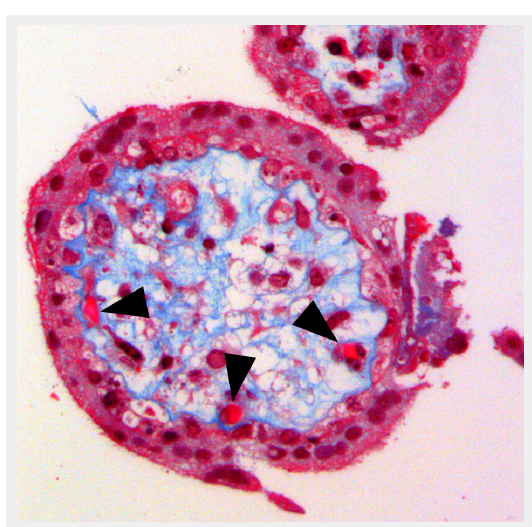
Histomorphology of a chorionic villus showing the outer trophoblastic coverage surrounding the inner foetal mesenchyme also comprising the foetal capillaries (black arrows). (Reprinted from: Weber B, Zeisberger SM, Hoerstrup SP. Prenatally harvested cells for cardiovascular tissue engineering: Fabrication of autologous implants prior to birth. Placenta. 2011;32(Suppl. 4):S316–9. © Elsevier, Oxford, UK, with kind permission).